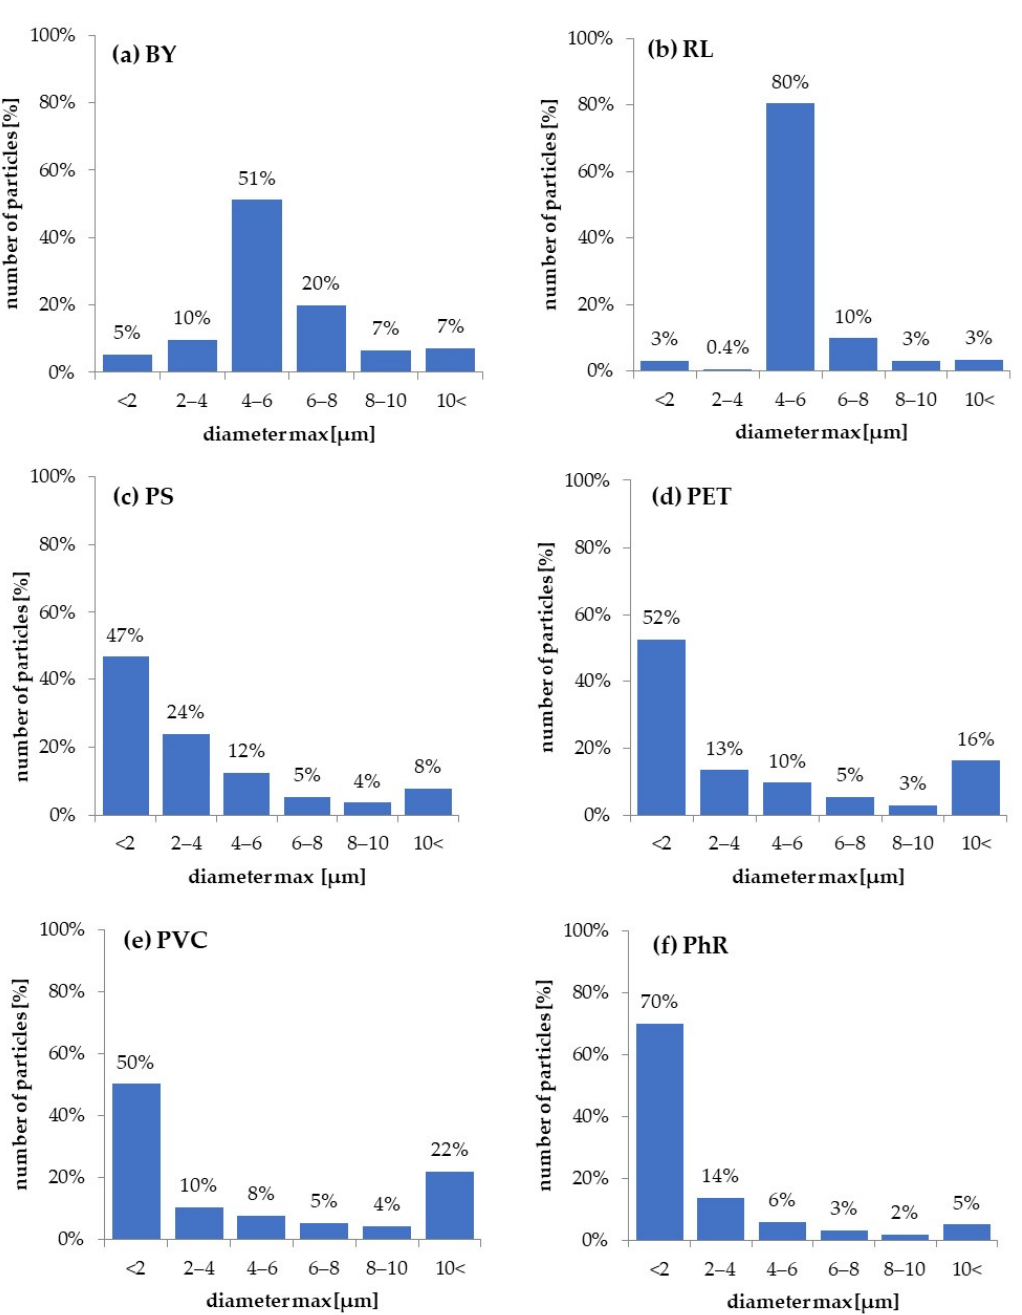
Figure 1. Size distribution of nano and small microparticles in the tested suspensions: ( a ) BY; ( b ) RL; ( c ) PS; ( d ) PET; ( e ) PVC; ( f ) PhR.